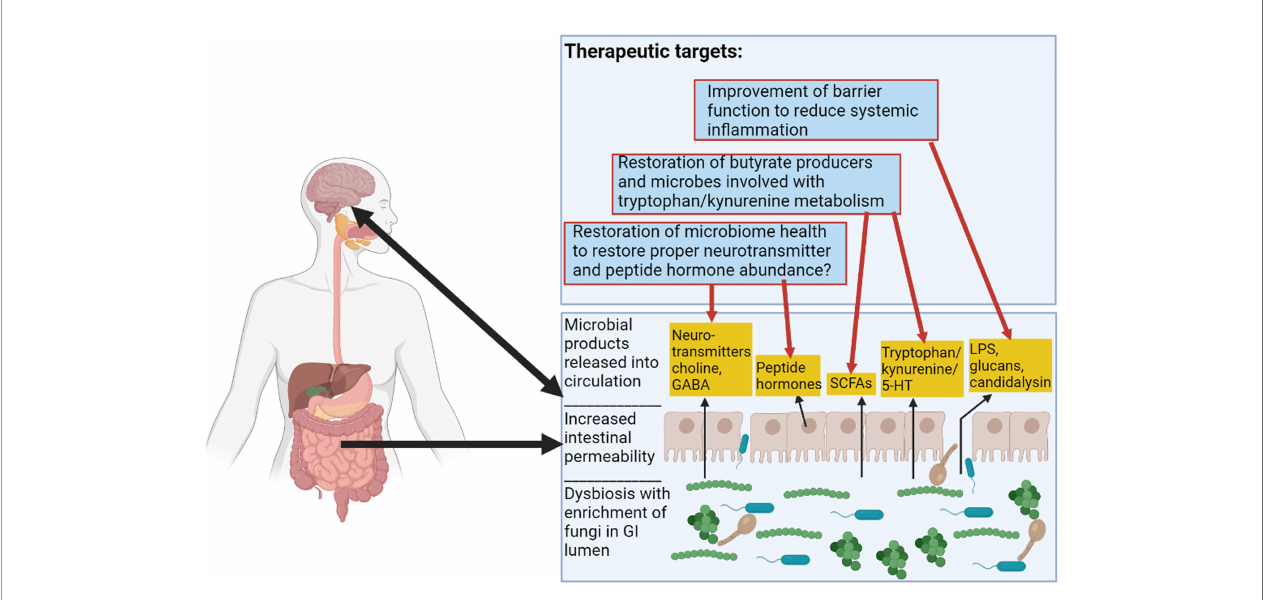
FIGURE 3 | Alcoholic Microbiome-Related Therapeutic Targets for Future Interventions. This fi gure illustrates alterations to the GI tract in alcoholism. There are functional changes such as alterations to SCFA (short-chain fatty acid) levels, alterations to tryptophan/kynurenine and 5-HT (serotonin) metabolite levels, increased intestinal permeability resulting in proximal and distal in fl ammation, and alterations to levels of hormones and neurotransmitters. Therapeutic targets are described in the top box and red arrows show some previously considered targets and speculative therapeutic targets pertaining to the microbiome in alcoholism. Figure created using